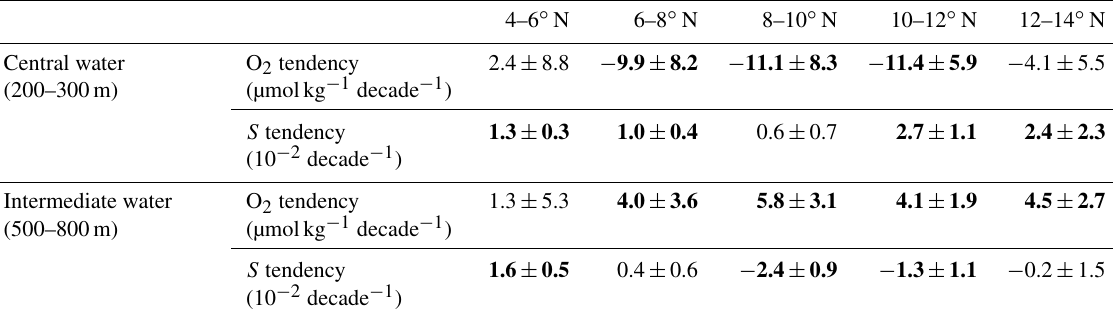
Table 3. Oxygen and salinity tendencies (2006–2015) with the 95% confidence interval estimated for five different latitude boxes along 23 ◦ W and for the central water (200–300m) and intermediate water (500–800m) layers, respectively. Oxygen tendency was estimated from shipboard observations (cf. Fig. 6a) and salinity tendency was estimated from float observations (cf. Fig. 6c). Bold values define regimes with a significant decadal